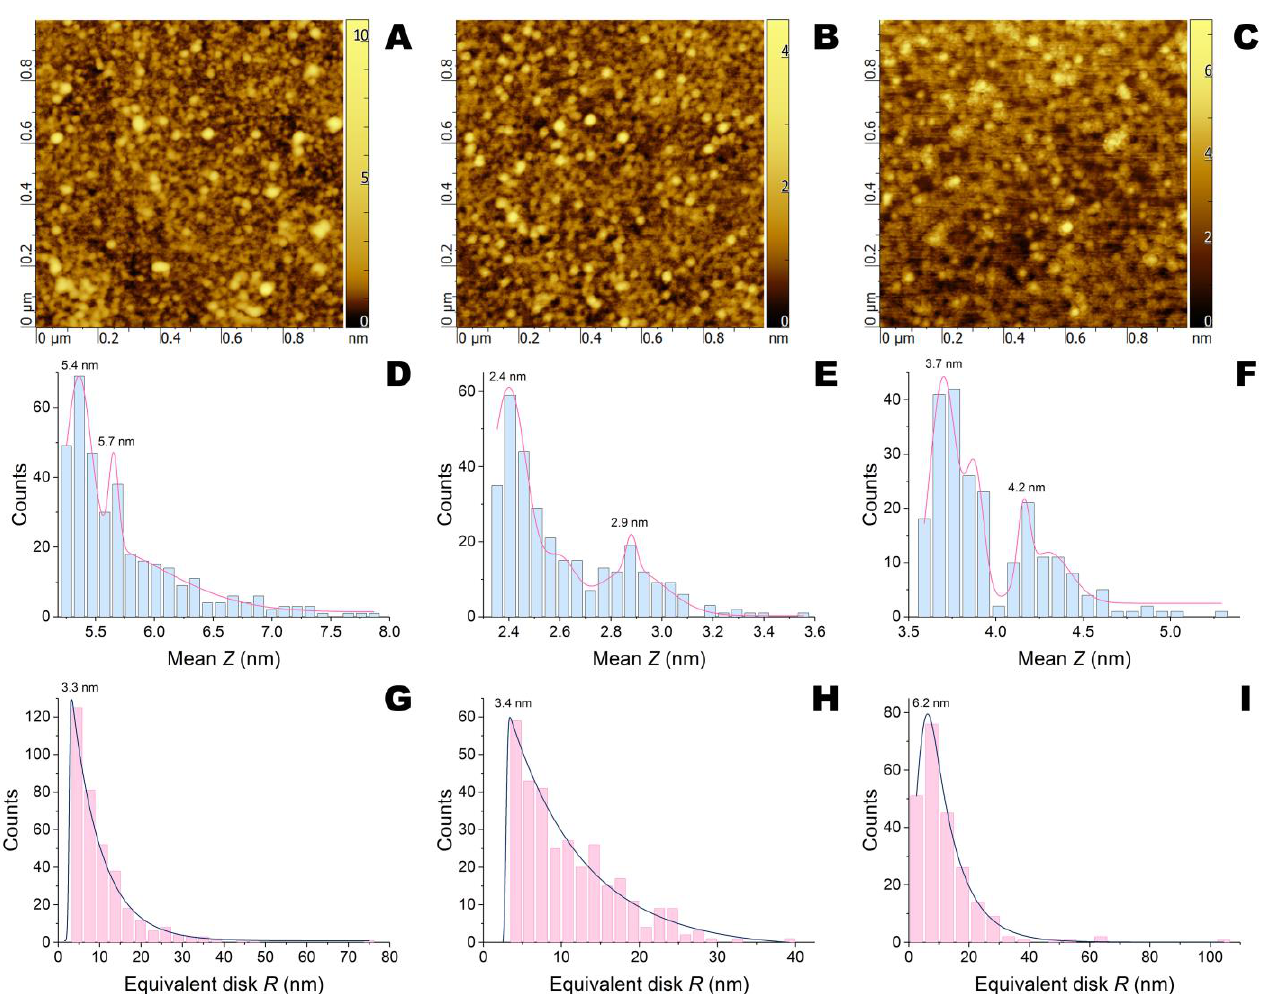
Figure 4. AFM images and their statistical treatment for APS-modified silicon wafers after application of penicillin acylase/PLE 50 without QS effectors ( A , D , G ) and with emodin ( B , E , H ) or naringenin ( C , F , I ).